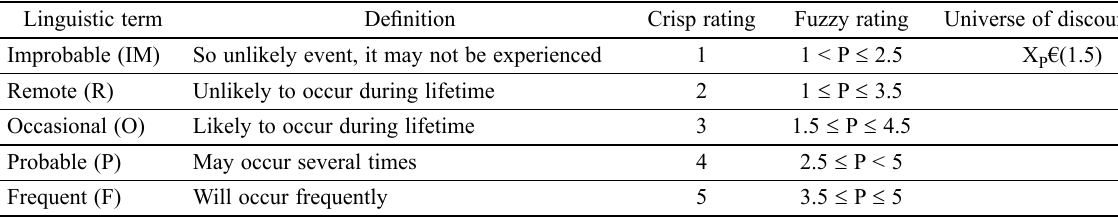
Table 1. Definition of probability levels